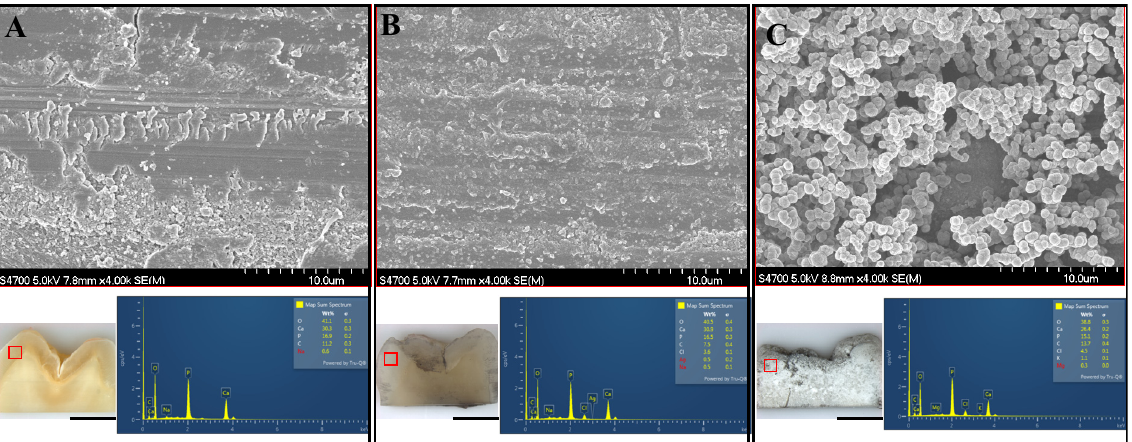
Figure 6. SEM images and corresponding EDS spectra from the enamel tissue of the dental slabs shown in Figure 5. Representative images are shown for: untreated sample ( A ); SDF-treated slab ( B ); shADP-AgBP peptide applied to SDF-treated silver-stained dental tissue slab ( C ). Scale bar for 10 × survey images ( A − C ) of dental tissue slabs is 1000 µ m. Representative EDS spectra to determine Ca/P averages calculated across a minimum of three unique areas for each region